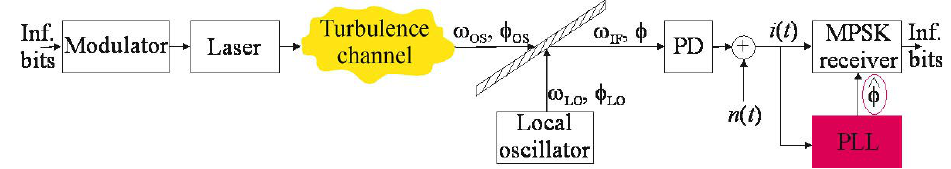
Figure 1. Model of the